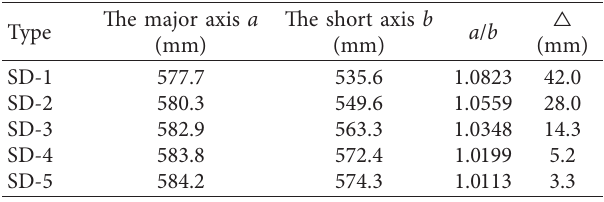
Figure 16: Horizontal section of test unit. Table 2: Size of horizontal section of specimens.